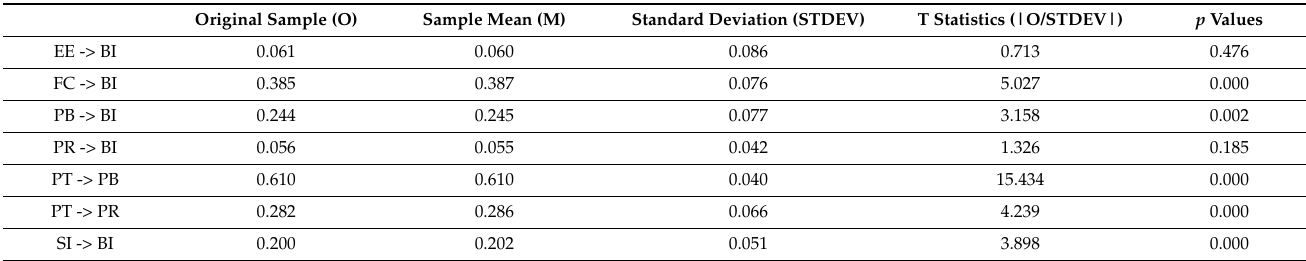
Figure 2. Path coefficient (T-values) results from SmartPLS. Table 8. Path coefficient values.